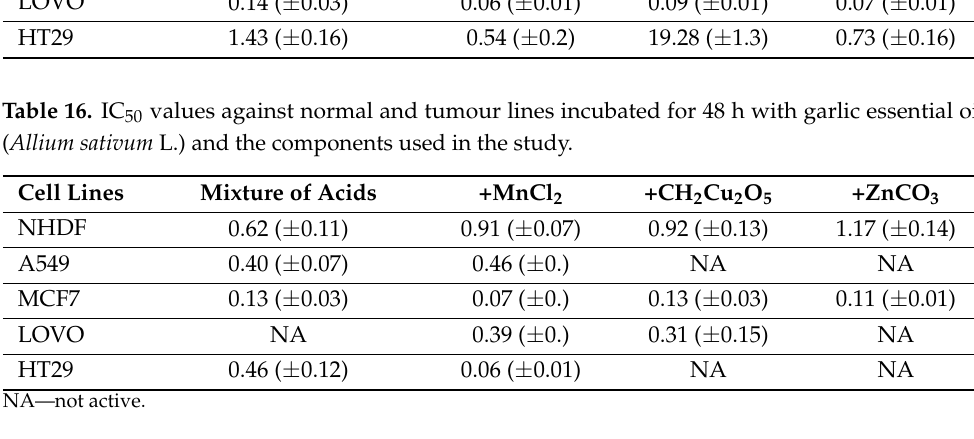
Table 17. IC 50 values against normal and tumour lines incubated for 48 h with clove essential oil ( Syzygium aromaticum (L.) Merr. and Perry) and the components used in the study. Cell Lines